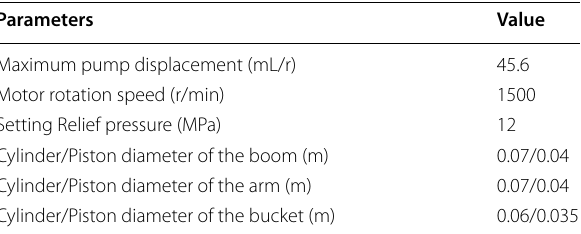
Table 3 Main parameters of the test rig